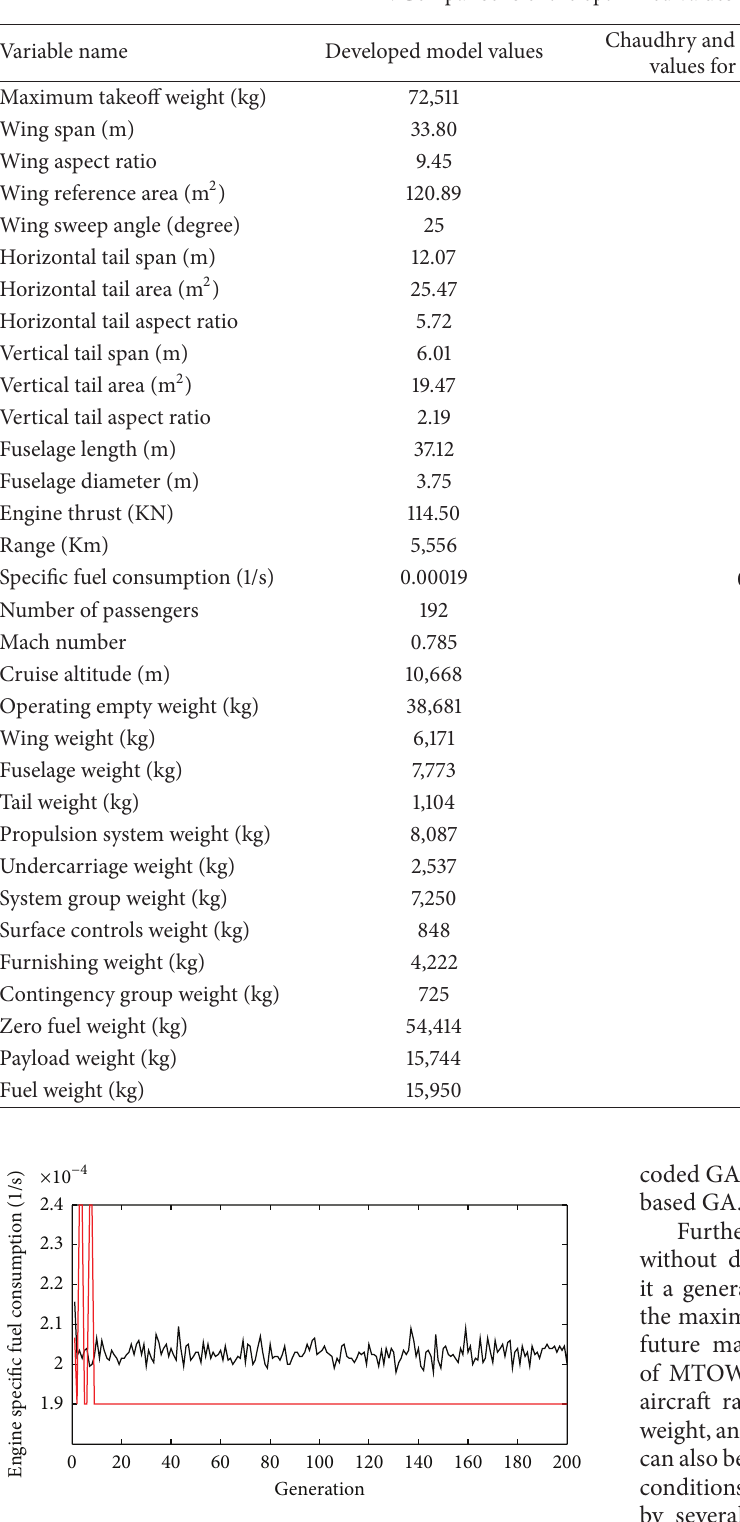
Table 2: Comparisons of the optimized values of decision variable.